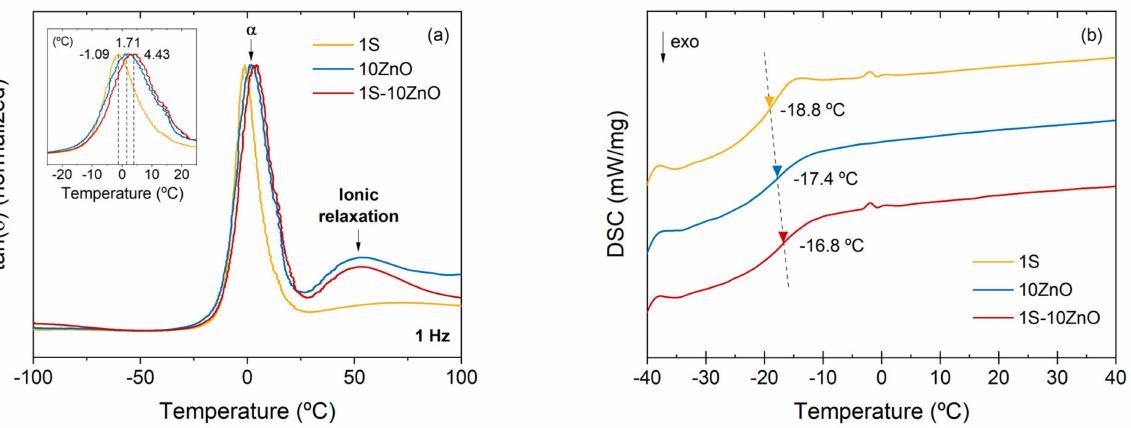
Figure 7. ( a ) DMA and ( b ) DSC spectra for prepared